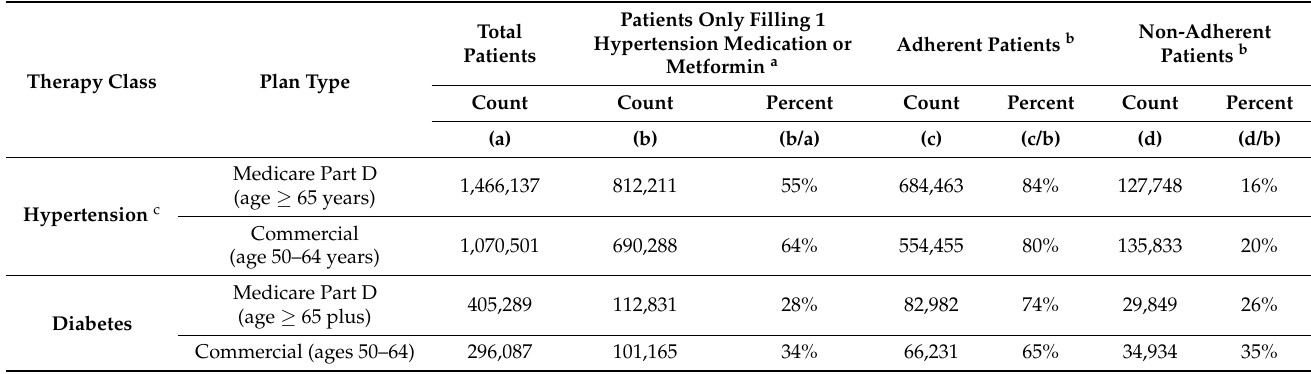
Table 1. Baseline adherence levels by therapy class, health plan type, and patient cohort.